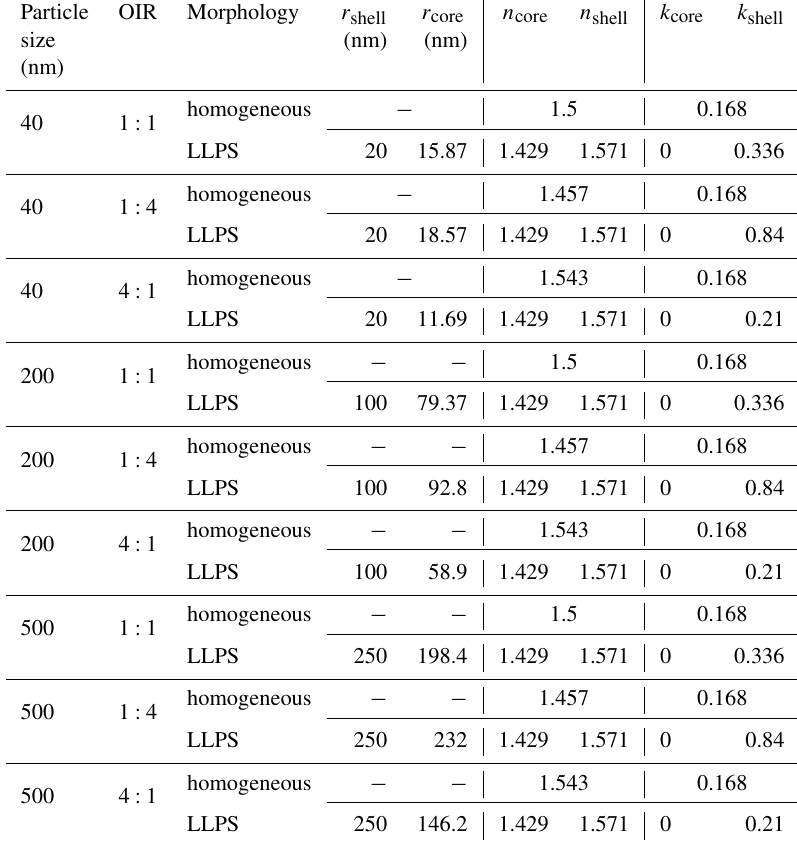
Table A1. Calculated values for relative size of the core to the shell for phase-separated particles and refractive indices ( k = 0 . 168) for homogenous and LLPS cases at different sizes and OIRs using volume mixing. Particle OIR Morphology r